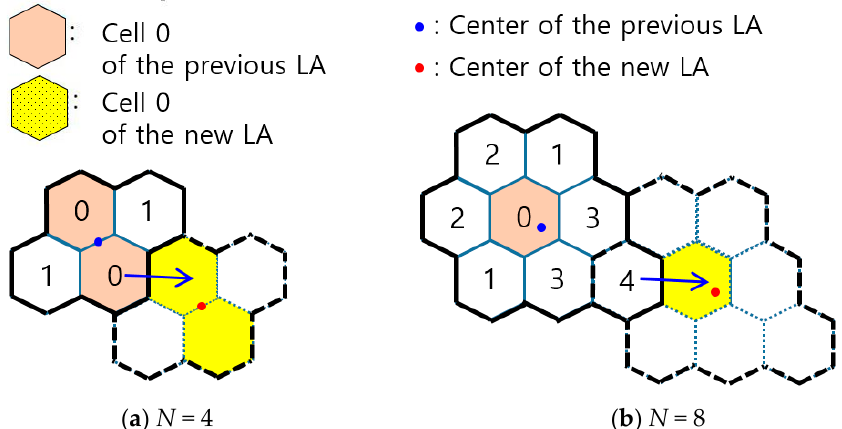
Figure 5. Registration and new location area in a cell-by-cell distance-based registration.